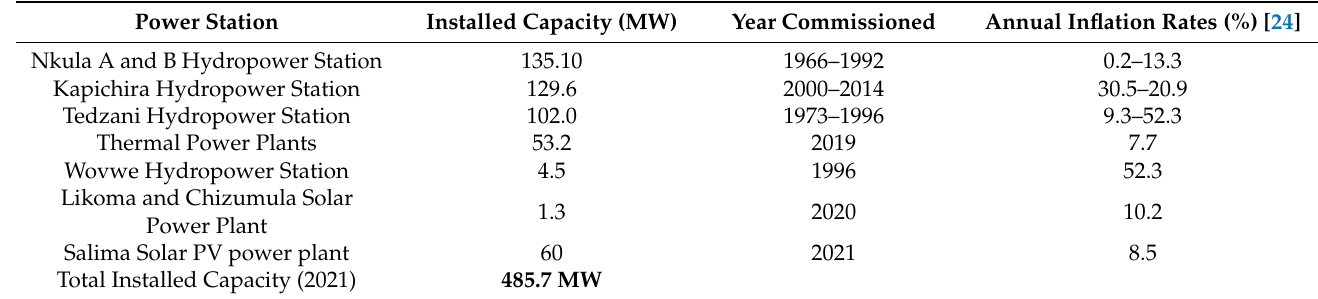
Table 1. Malawi’s total installed capacity (adapted from